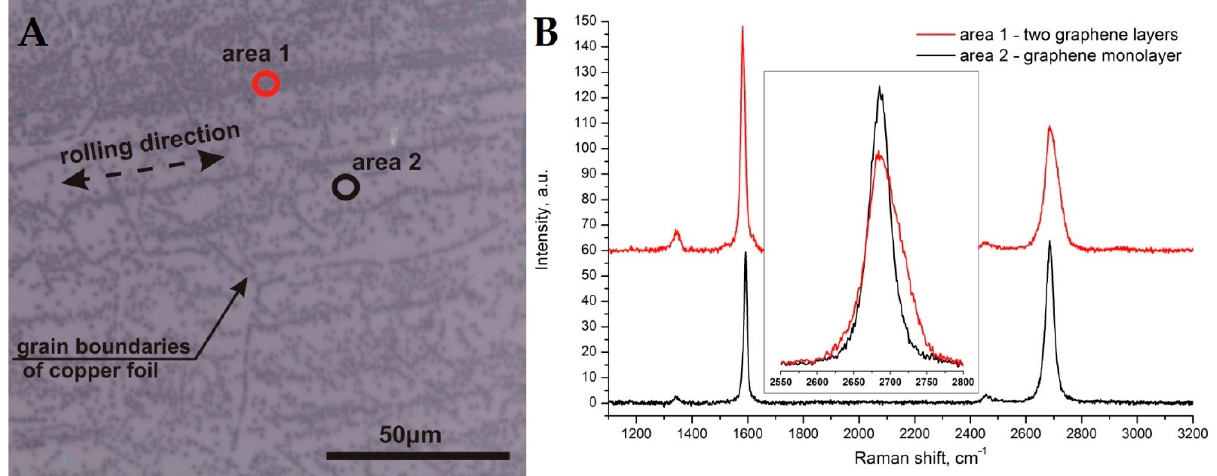
Figure 1. Optical image of graphene on Si/SiO 2 90 nm ( A ). Raman spectra of different graphene areas ( B ).